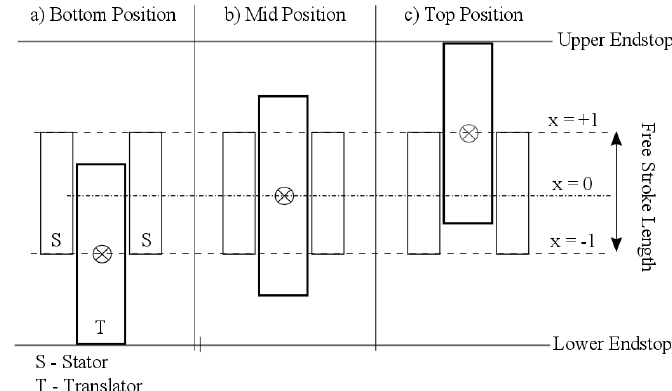
Figure 1. Illustration of different translator positions and partial stator overlap. In the mid position the stator is fully overlapped by the translator ( A frac = 1), whereas, when the translator is at its bottom or top position, the stator is not completely overlapped by the translator ( A frac < 1). ( a ) Bottom Position; ( b ) Mid Position; ( c ) Top